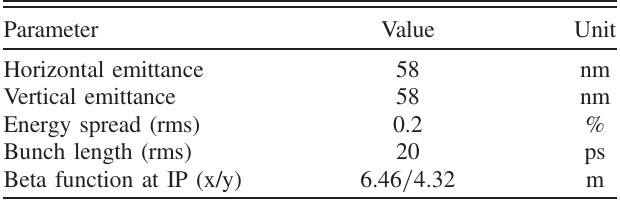
TABLE III. Initial particle